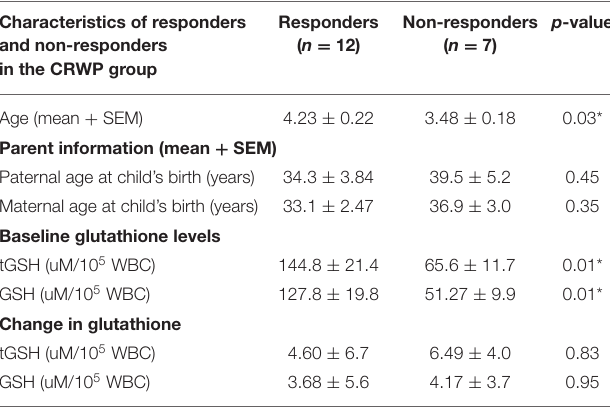
TABLE 4 | Demographics and glutathione levels of responders ( n = 12) and non-responders ( n = 7). Characteristics of responders and